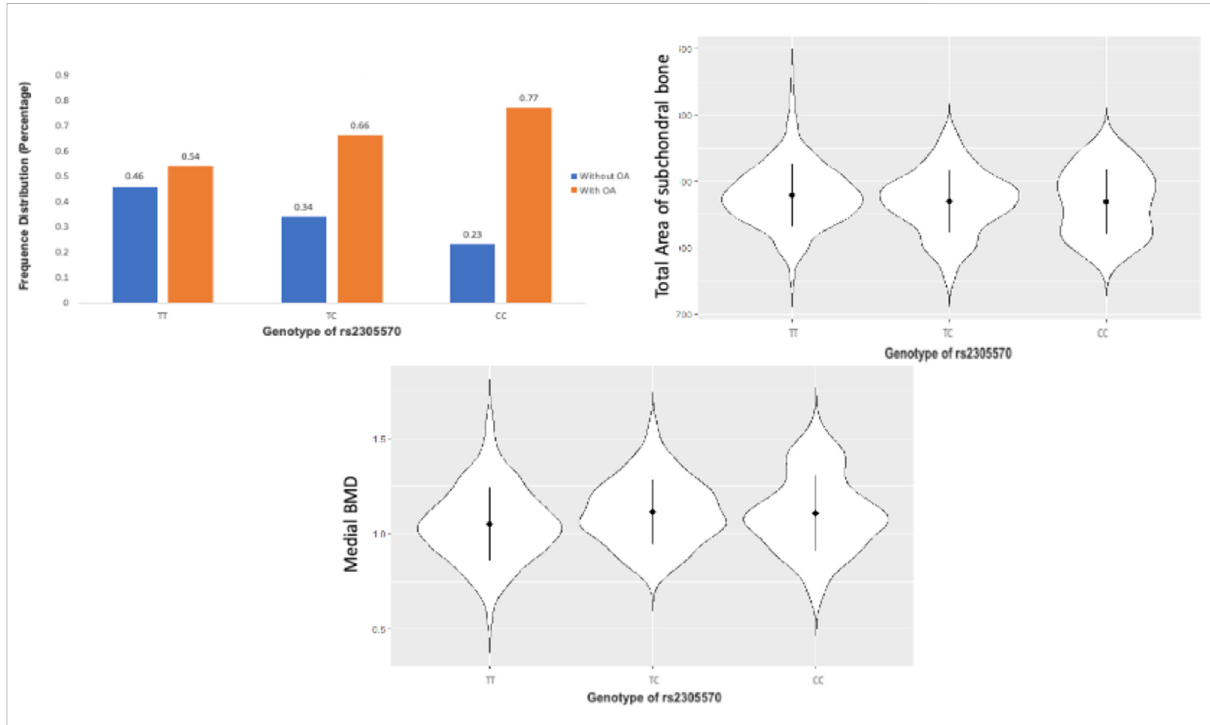
FIGURE 6 The TT, TC, and CC genotypes of rs2305570 had a different performance on the total area of subchondral bone, and medial